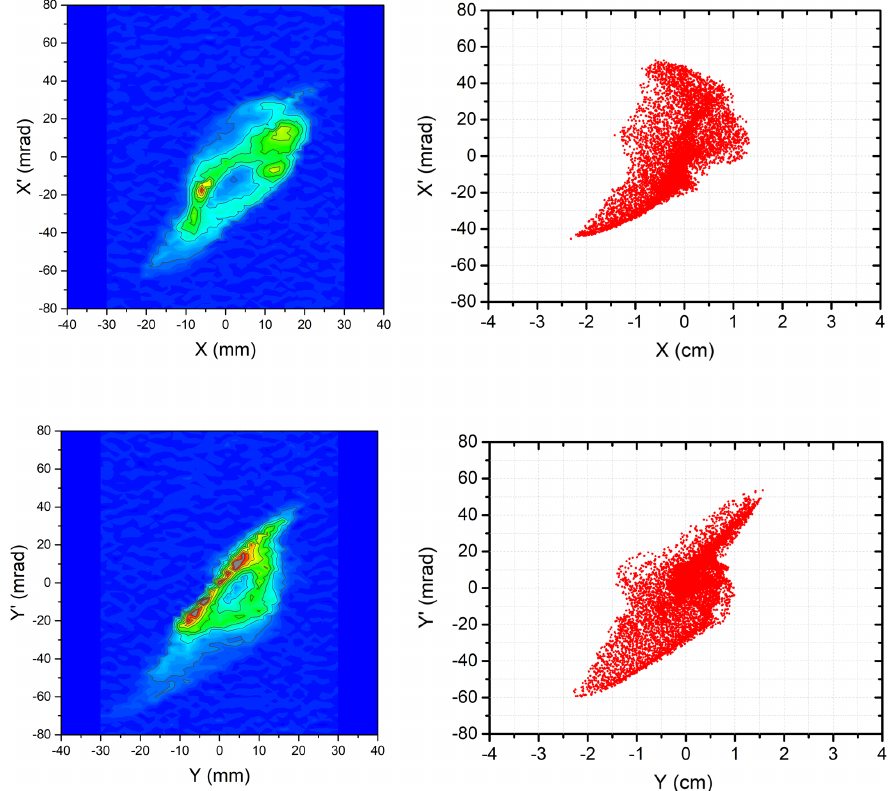
FIG. 6. Phase space comparison between measurement (left) and simulation